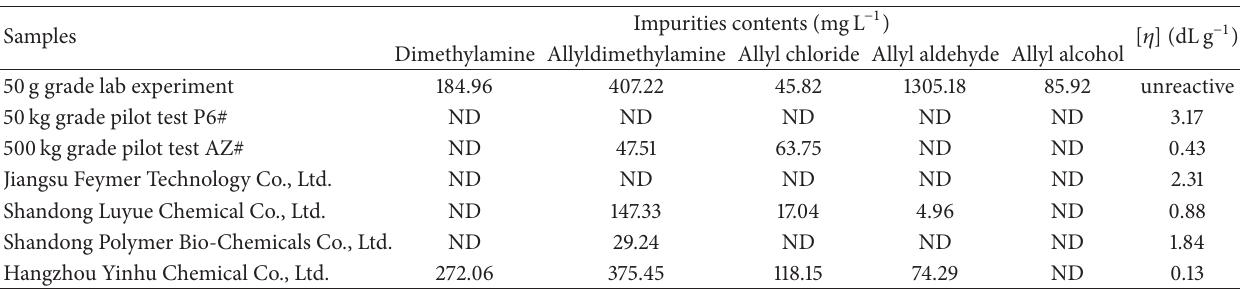
Table 4: Analytical results for several real DADMAC